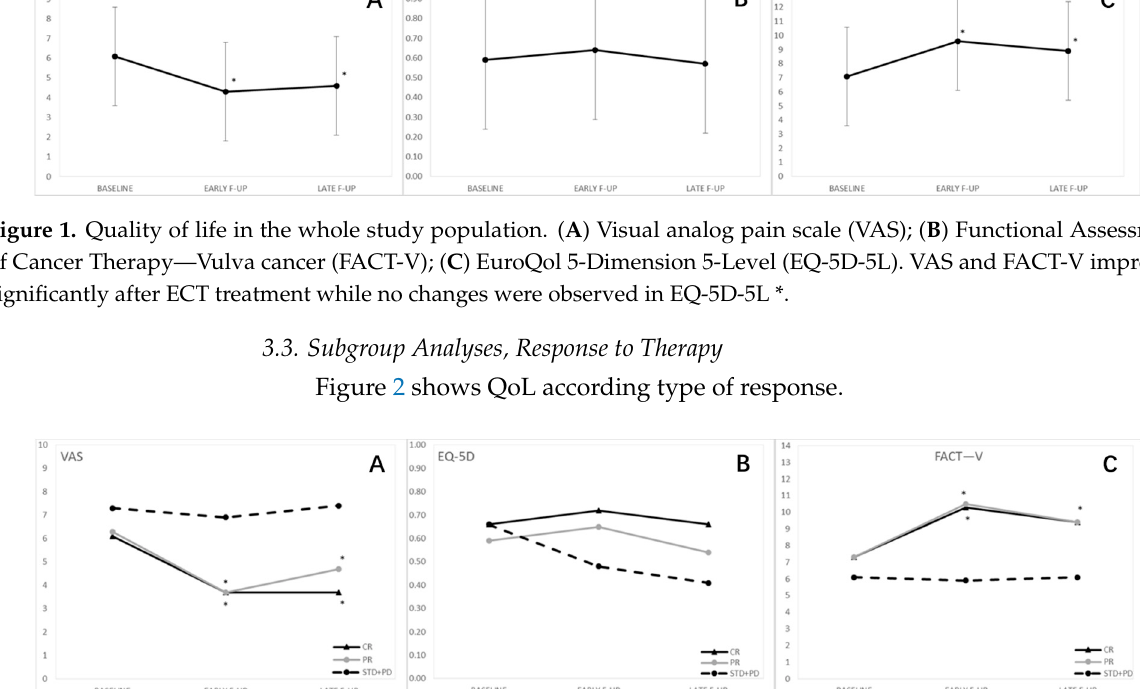
Figure 2. Quality of life by type of response. ( A ) Visual analog pain scale (VAS); ( B ) Functional Assessment of Cancer Therapy—Vulva cancer (FACT-V); ( C ) EuroQol 5-Dimension 5-Level (EQ-5D-5LQuality of life improved after ECT treatment if we consider the VAS and FACT-V scores, while no significant differences were observed between the three groups at baseline or at each follow-up for EQ-5D-5L scores. *